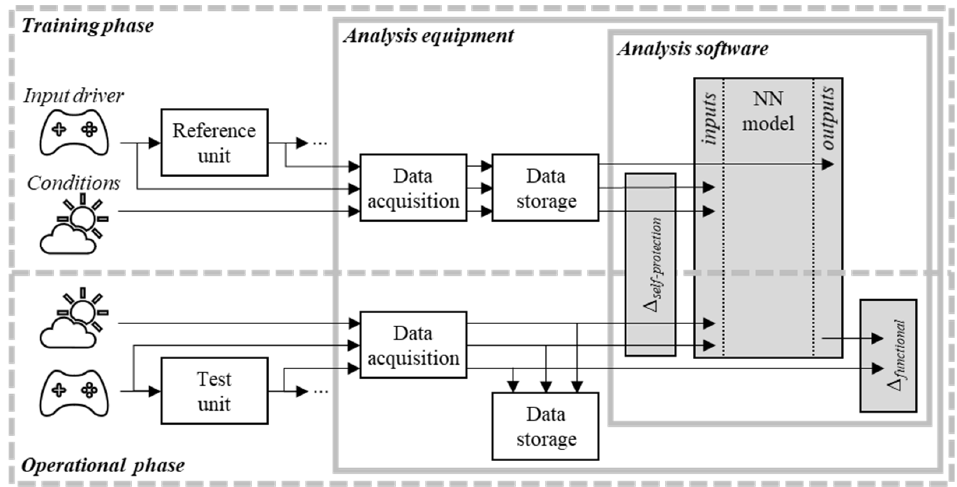
Figure 1. Schematic of the proposed method.